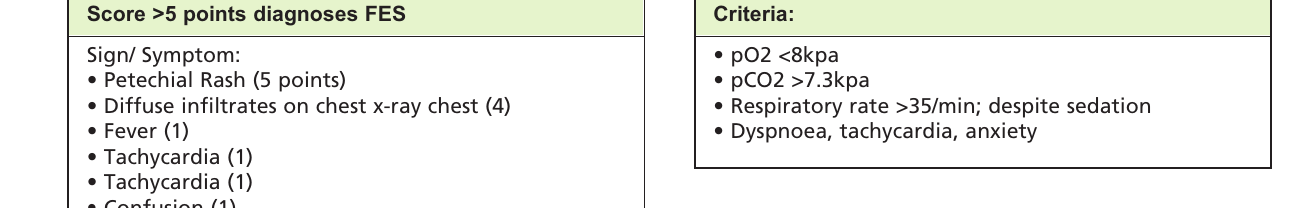
Lindeque’s Criteria for FES 5 Table IV: